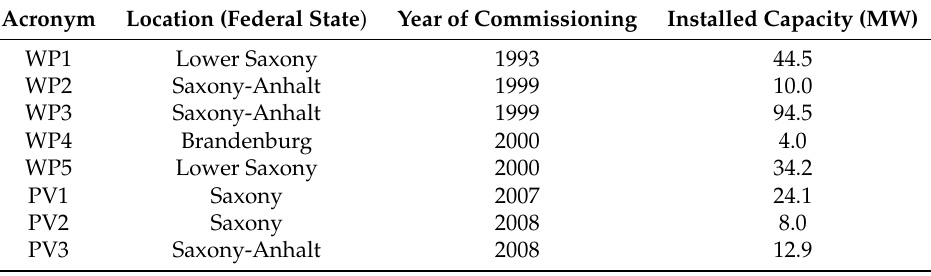
Table 1. Onshore wind and PV power plants considered in the case